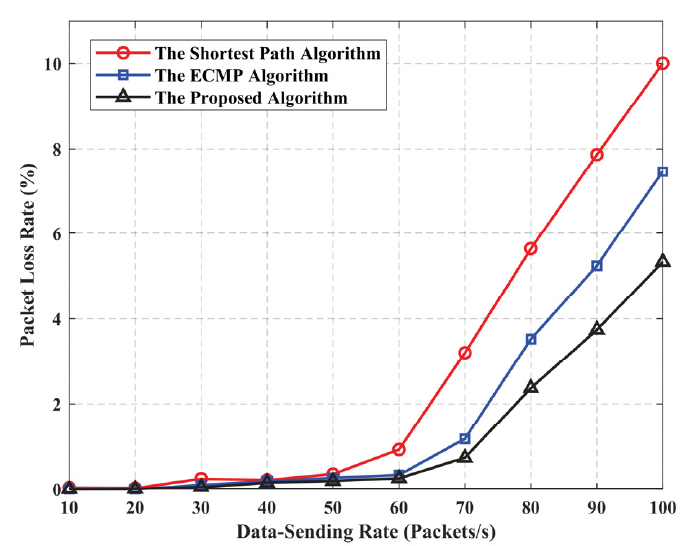
Figure 8. Packet loss rate at di ff erent data sending rates.